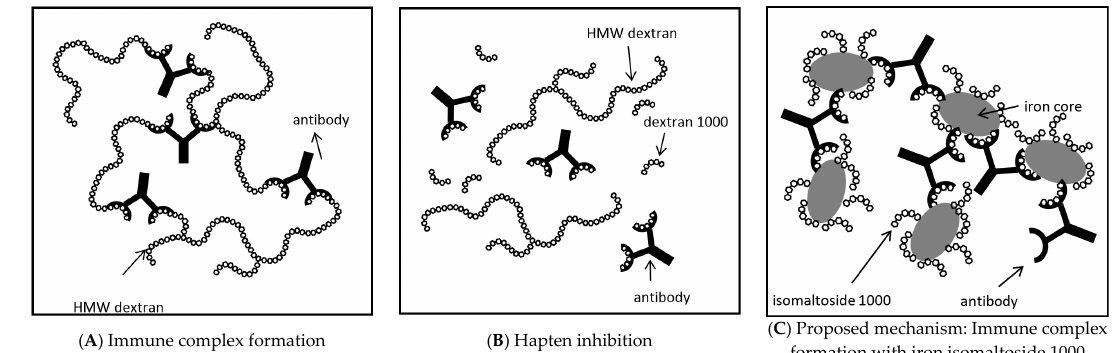
Figure 2. Schematic illustration of immune complex formation and inhibition. ( A ) Immune complex formation with high molecular weight (HMW) dextran and anti-dextran antibody. A large insoluble complex is generated, which may trigger DIARs; ( B ) Inhibition of immune complex formation by dextran 1000, i.e., hapten prophylaxis. Dextran 1000 binds to the anti-dextran antibody without formation of an immune complex and thus does not induce any immune response. The anti-dextran antibody is no longer available for binding to the HMW dextran, which thus is less likely to induce DIARs; ( C ) Proposed mechanism of the observed in vitro multivalent immune complex formation with iron isomaltoside 1000 (IIM) and anti-dextran antibody. In IIM, a number of isomaltoside 1000 (reduced dextran 1000) units are attached to the polynuclear iron core. The presented in vitro results suggest that IIM can act as a polyvalent higher molecular weight dextran and lead to immune complex formation. As in ( A ), a large insoluble complex is formed, which may trigger DIARs. ( A , B ) Based on Richter et al. [40].